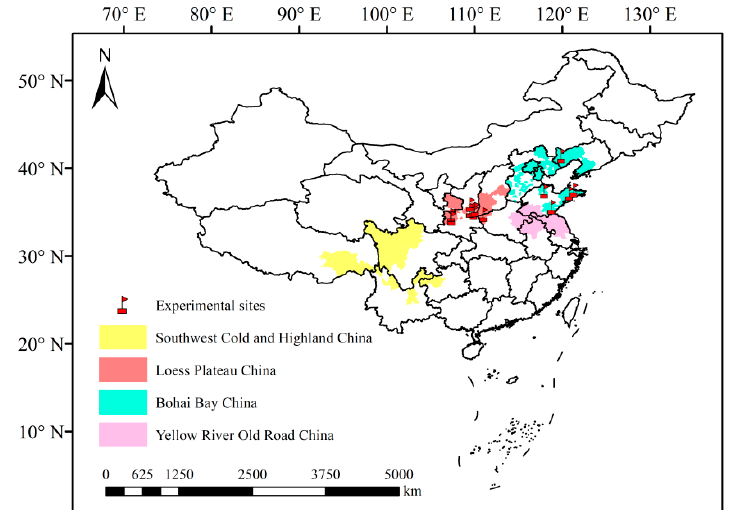
Figure 1. Geo-location of the four major apple cultivation areas in China and the specific apple orchard test sites in the literature compiled by meta-analysis.